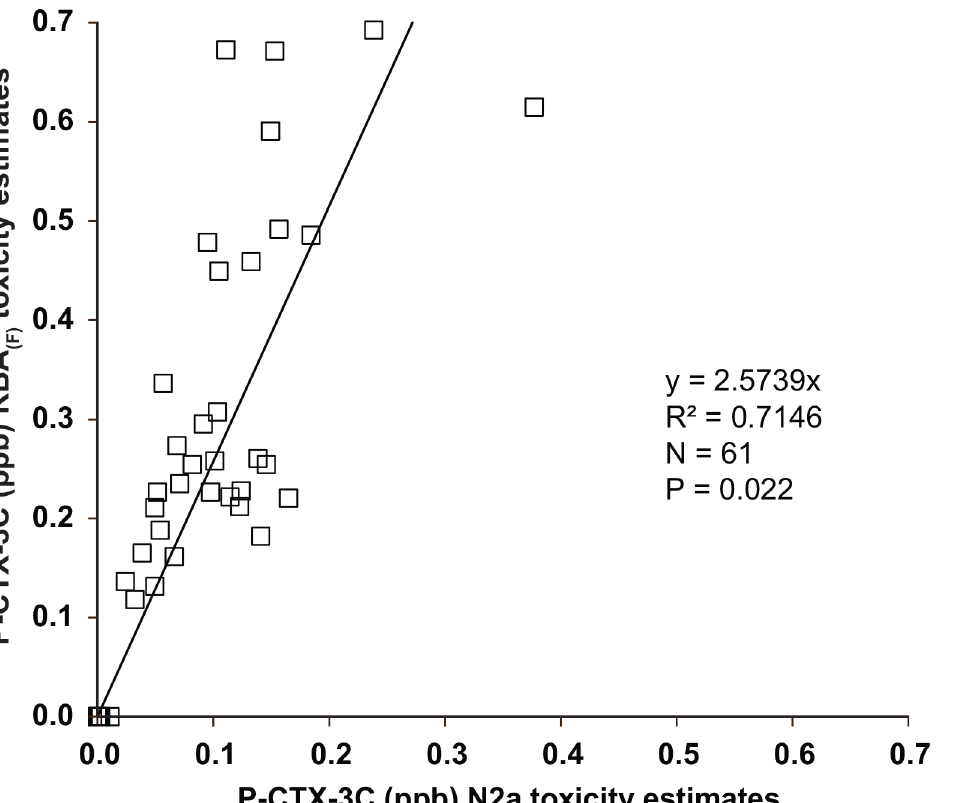
Fig 8. RBA (F) and CBA-N2a Results Comparison. Linear regression between the ciguatoxin concentrations measured in sixty-one duplicate fish extracts using the RBA (F) and